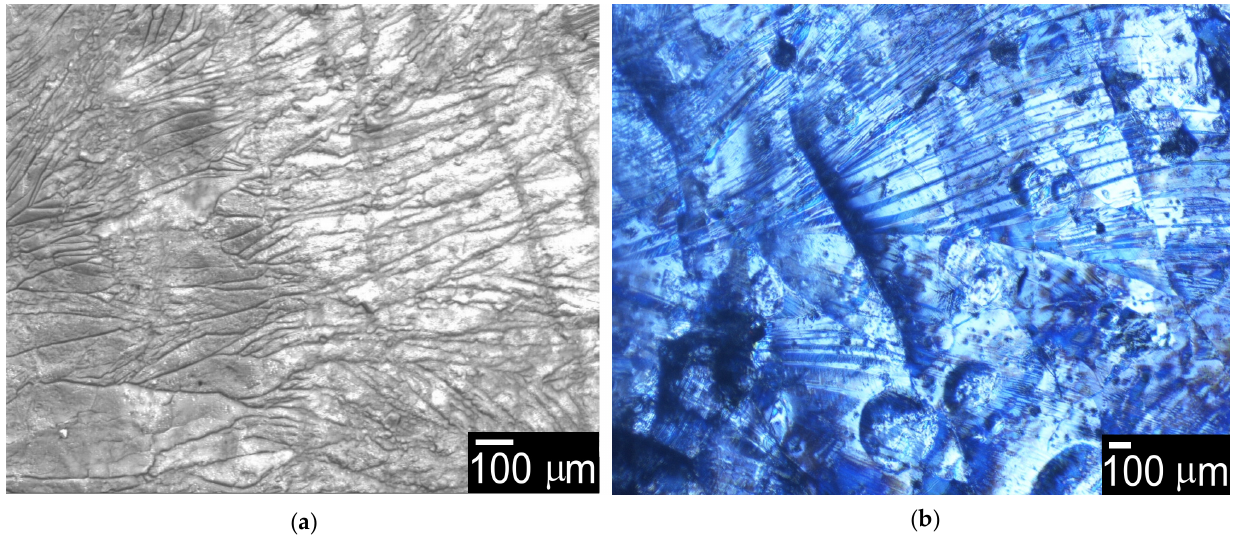
Figure 16. ( a ) SEM image of poly(bithiophene) deposited on V-CB(PANI); ( b ) Optical microscopy image of poly(bithiophene) on V-CB(PANI).